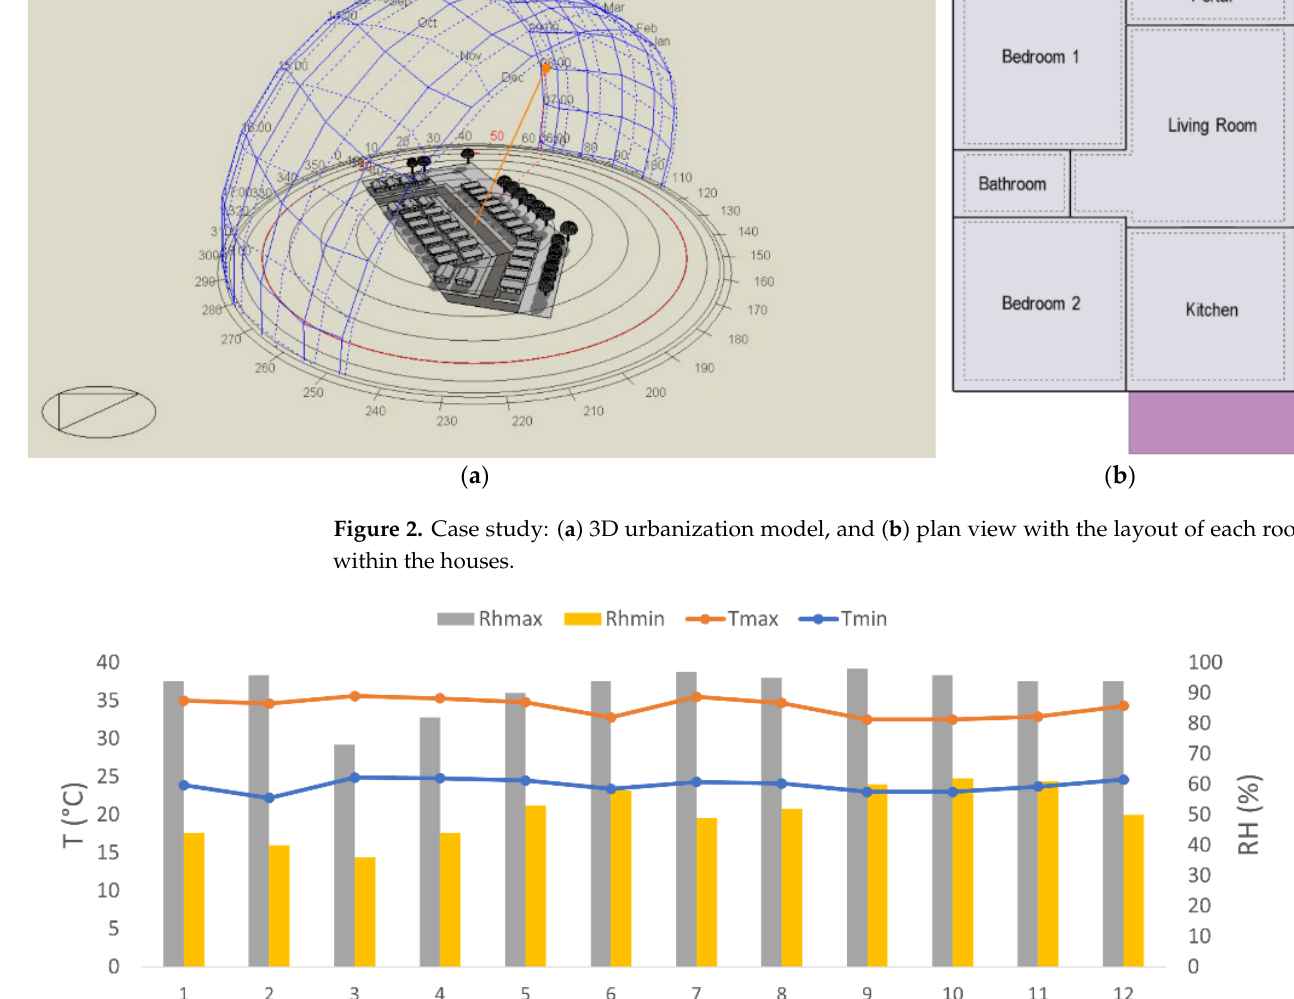
Figure 3. Comparison between maximum and minimum temperatures and relative humidity for each month of the year.